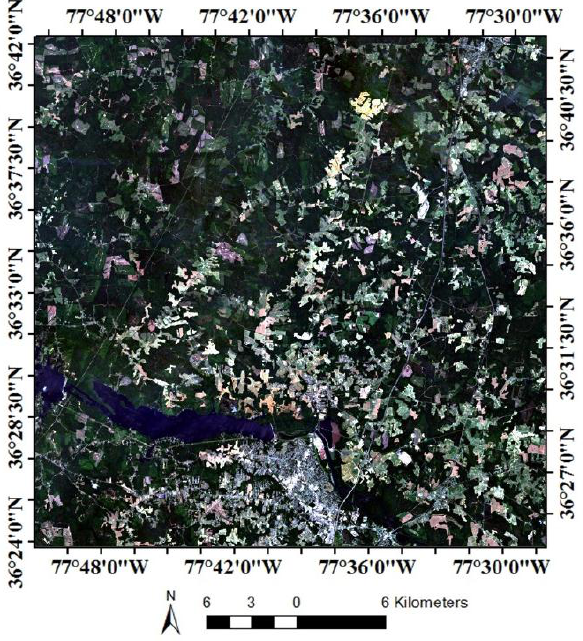
Figure 4. Landsat-8 OLI data acquired on 13 July 2014 after the removal of clouds. The color composite is with Band 4 as red, Band 3 as green, and Band 2 as